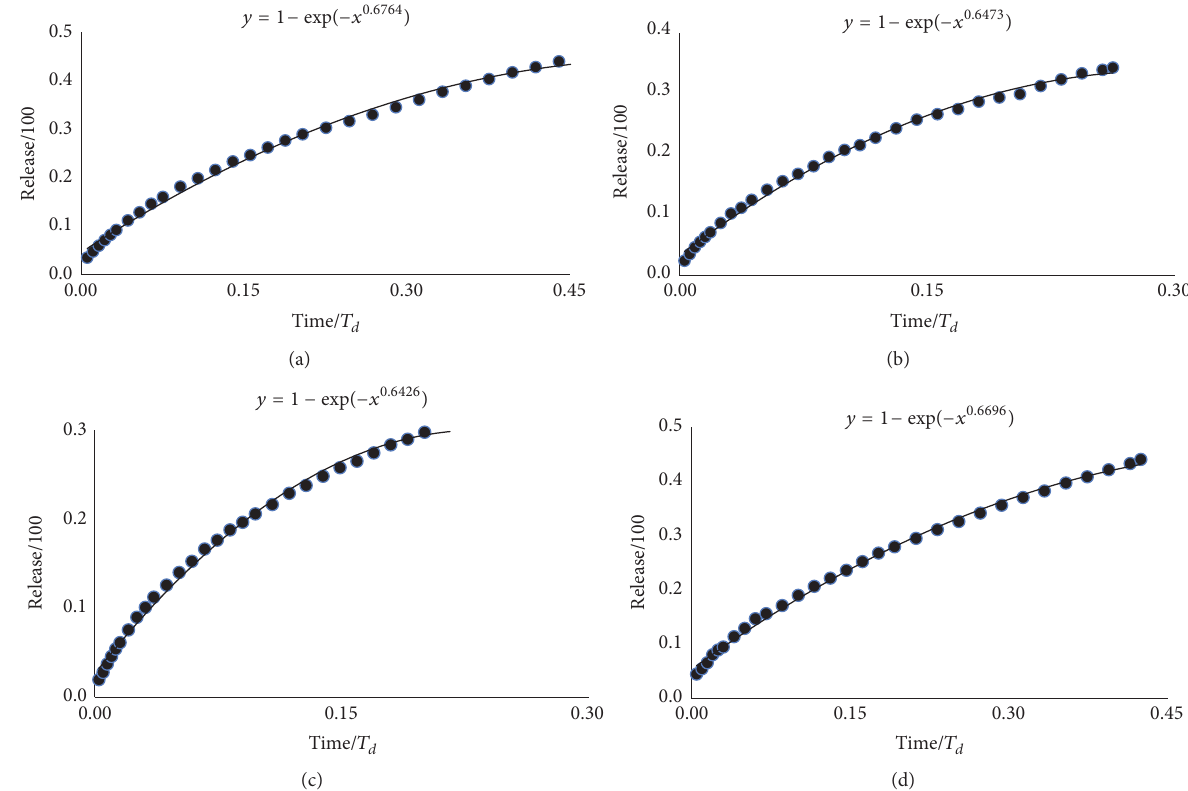
Figure 4: Courses of EH release in Weibull model applied for formulation: (a) MC, (b) PA1, (c) PC-11, and (d) PA2.